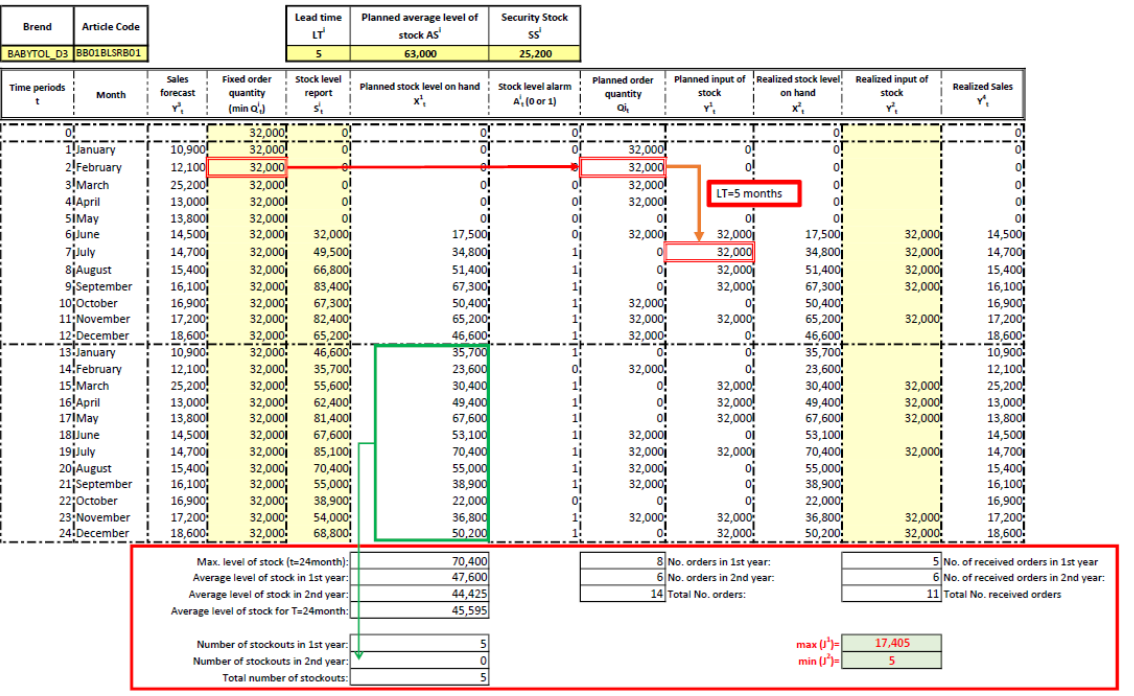
Figure 6. Elements of the spreadsheet model for Case 1: FOQ policy with deterministic demand.